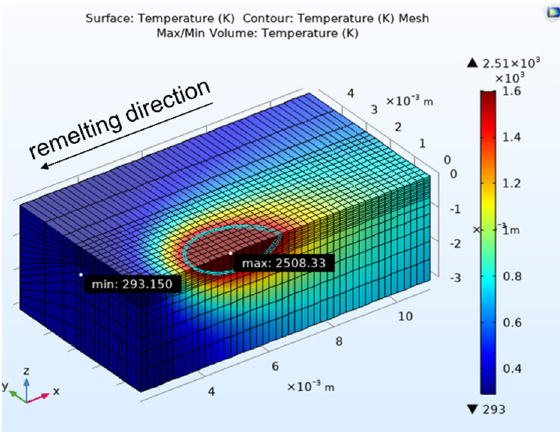
Figure 7. Stationary temperature field calculated by the heat conduction model with P = 1000 W, v